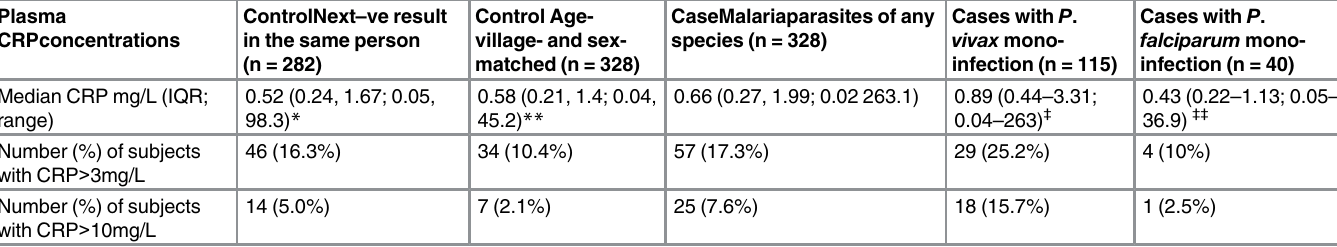
Table 2. CRP values and distributions in cases and controls. Plasma